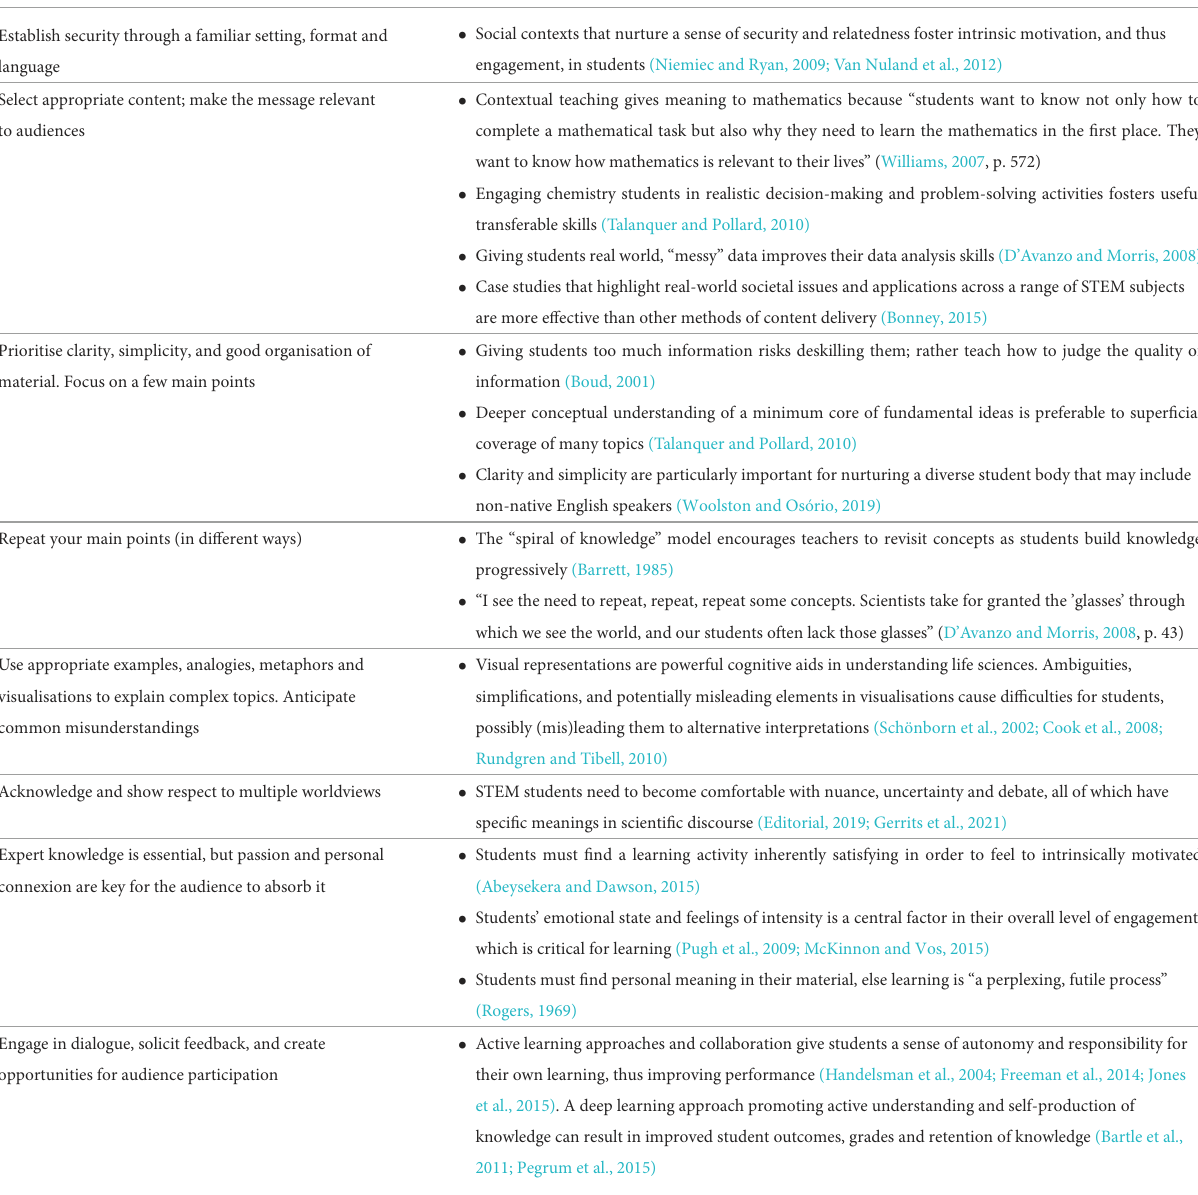
TABLE 1 A synthesis of best practices in scicomm (adapted from Sevian and Gonsalves, 2008; Bell et al., 2009; Kapon et al., 2009; Somerville and Hassol, 2011; Baram-Tsabari and Lewenstein, 2013; Knudsen and de Bolsée, 2019; and refs therein; Longnecker and Gondwe, 2014; Longnecker, 2016; Olson, 2018; Fleming et al., 2020; Wilkinson et al., 2020; Olson, 2021; Longnecker, 2022) and their relationship with pedagogical findings or examples applicable to higher